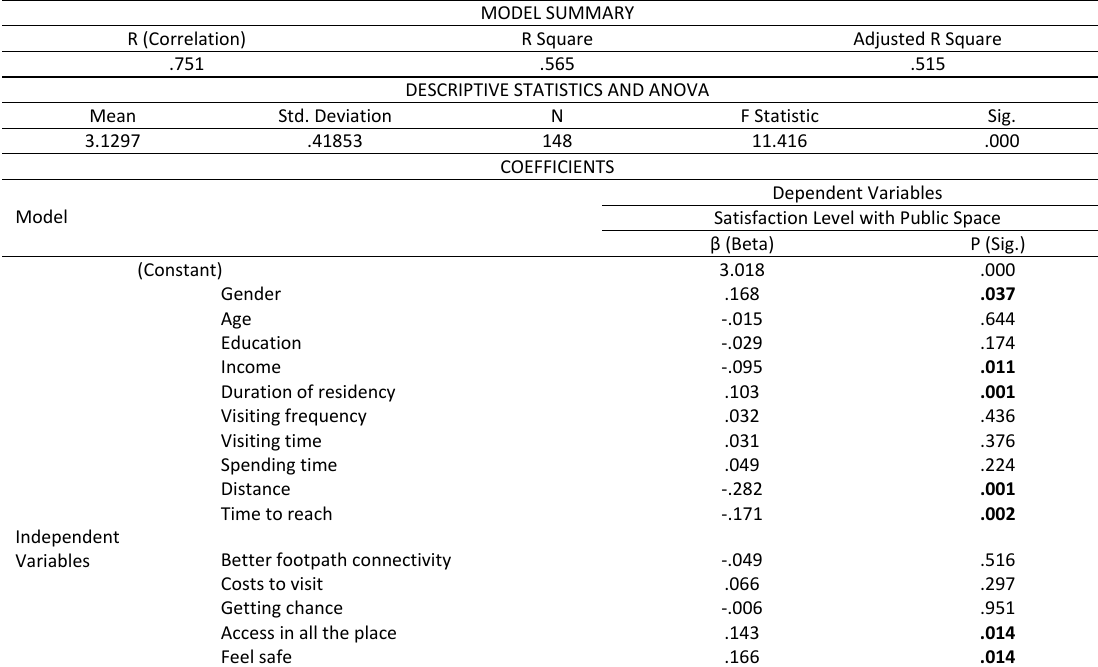
Table 6: Multiple regression model analysis of satisfaction level with public space MODEL SUMMARY